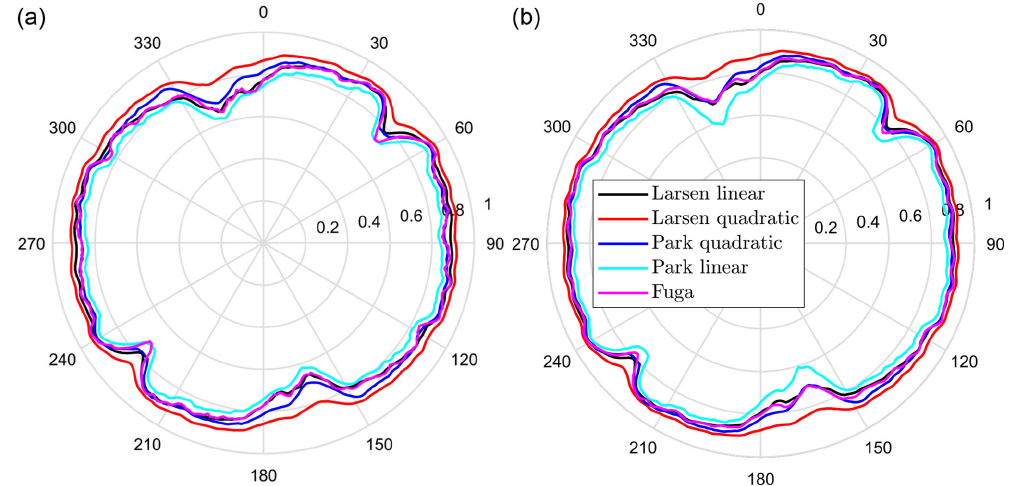
Figure 3. The efficiency of the Anholt wind farm predicted by the wake models at 5ms − 1 (a) and 10ms − 1 (b) .